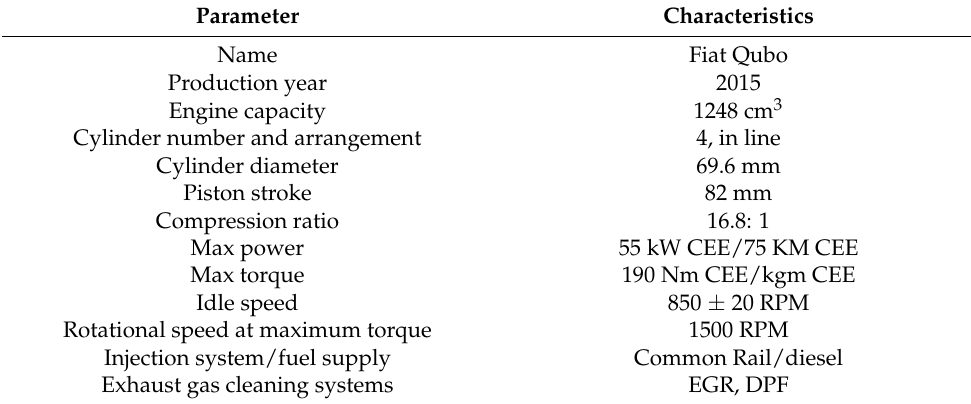
Table 1. Main characteristics of Fiat Qubo vehicle used for the tests.